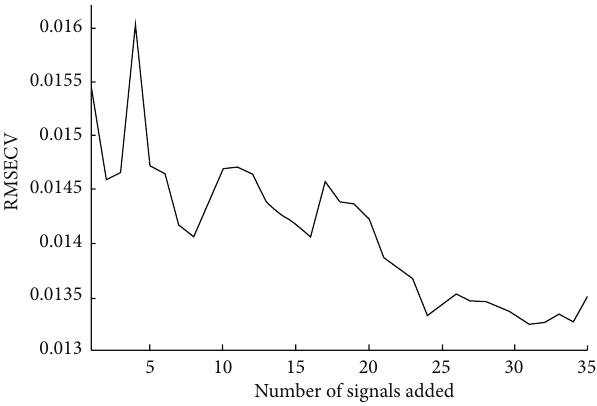
Figure 2: RMSECV versus the number of added signals.